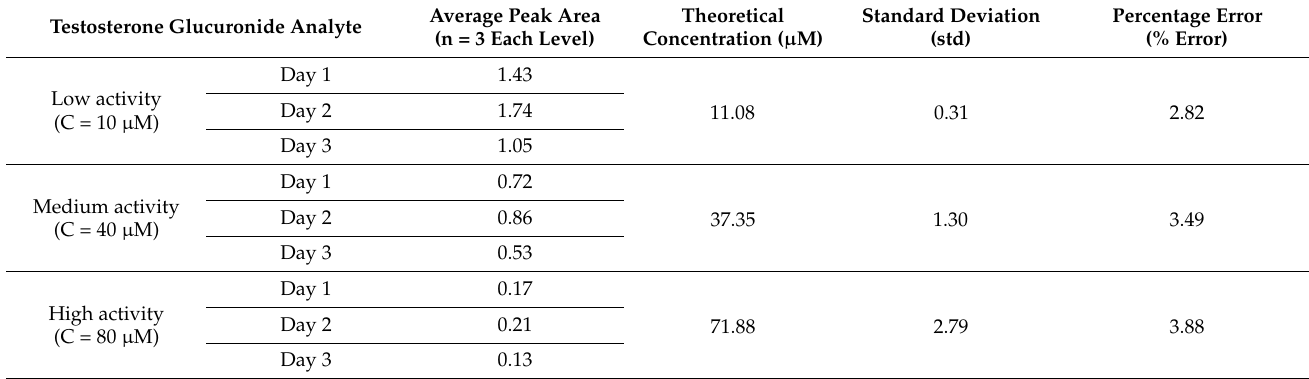
Table 10. Testosterone glucuronide inter-assay precision